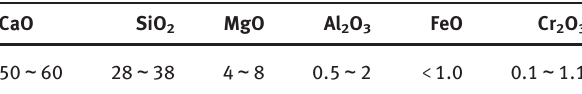
Table 1: Typical chemical composition of 304 stainless steel refining slags in GOR,